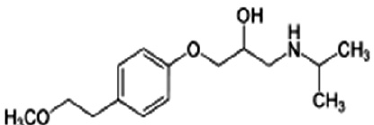
(1) Figure 1. Molecular structure of metoprolol (RS)-1-(isopropylami-